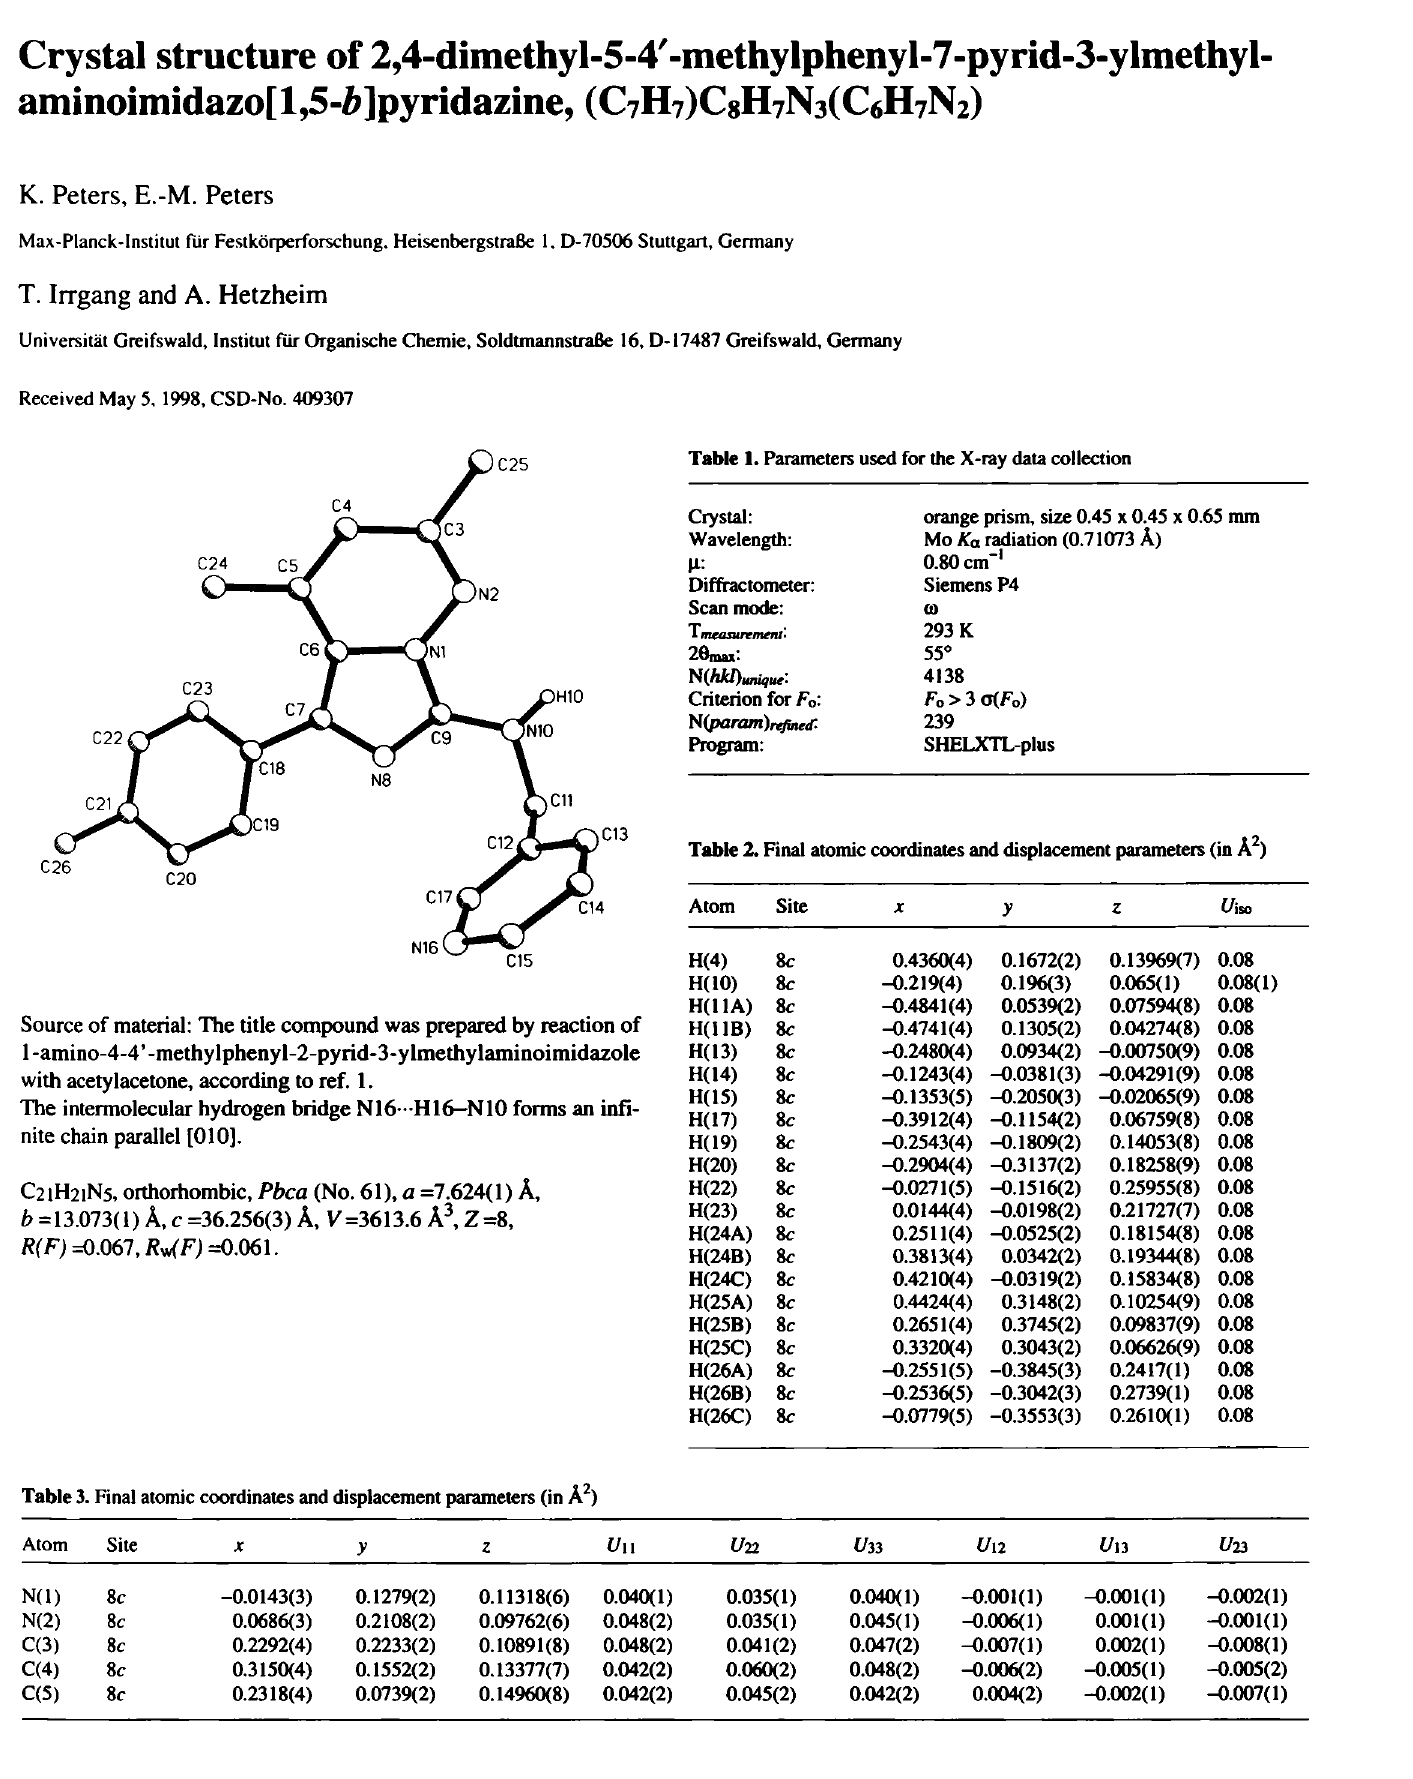
Table 1. Parameters used for the X-ray data collection